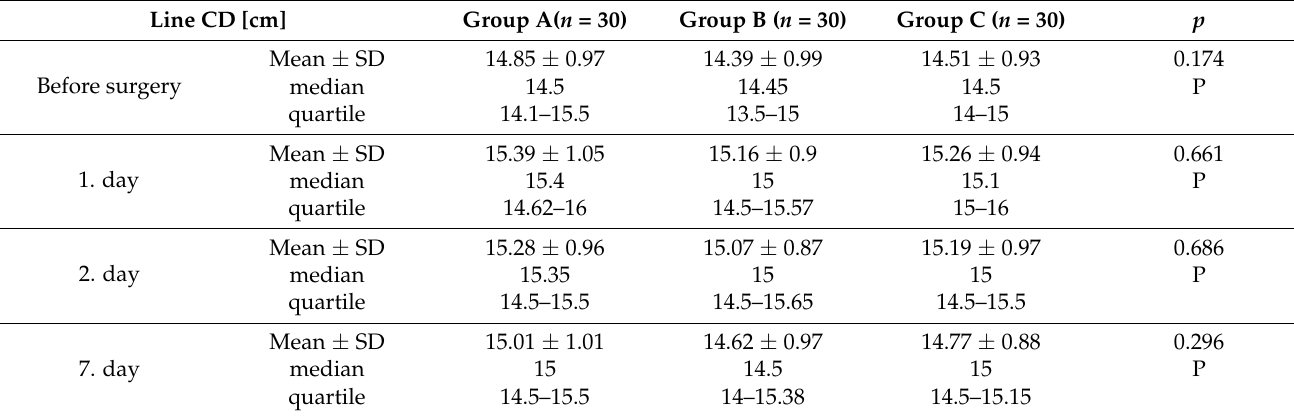
Table 7. Results of comparative analysis of CD line length before treatment and on day 1, 2, and 7 after treatment between groups A, B,